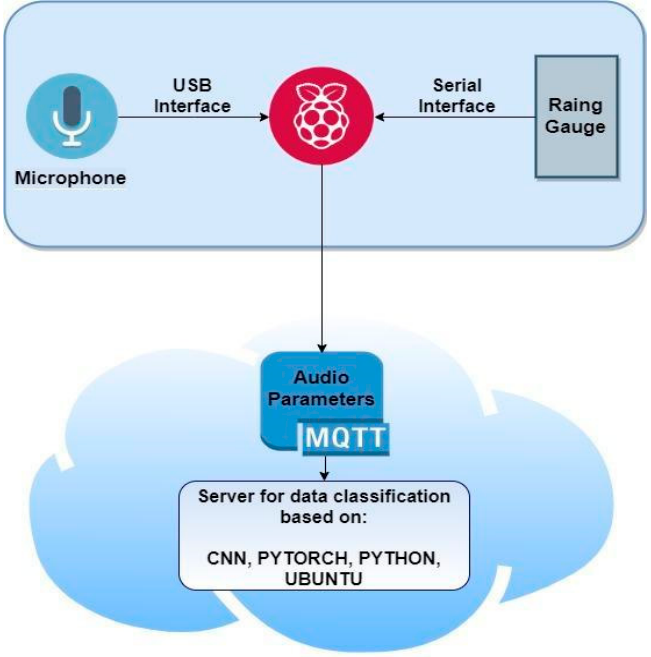
Figure 3. Hardware and software scheme.